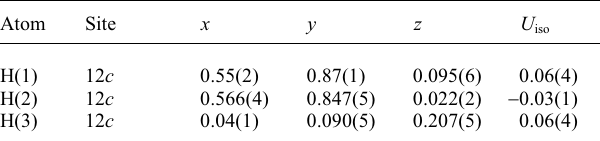
Table 2. Atomic coordinates and displacement parameters (in Å 2 )